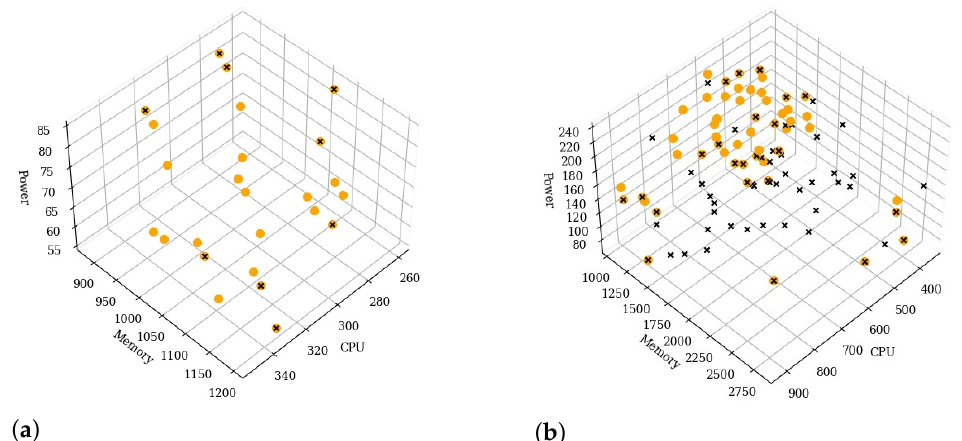
Figure 8. Multi-objective optimization results for Systems 1 and 9. ( a ) Pareto fronts for System 1; ( b ) Pareto fronts for System